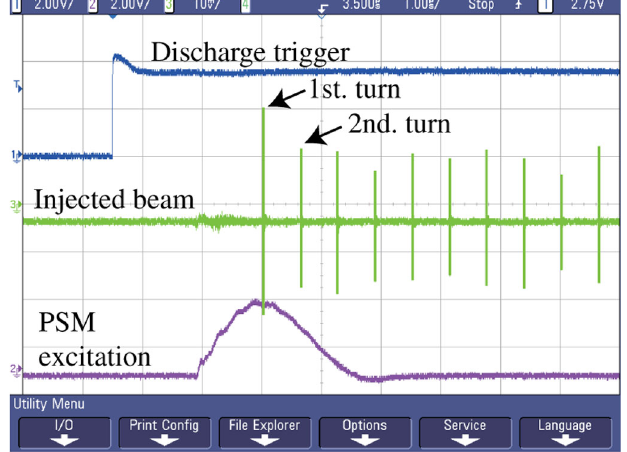
FIG. 17. (Color) Typical waveforms of a discharge trigger (blue), an injected beam signal from a wall current monitor of the ring (green), and a PSM excitation signal from a current transformer of the pulsed power supply (purple) measured by a digital oscilloscope.